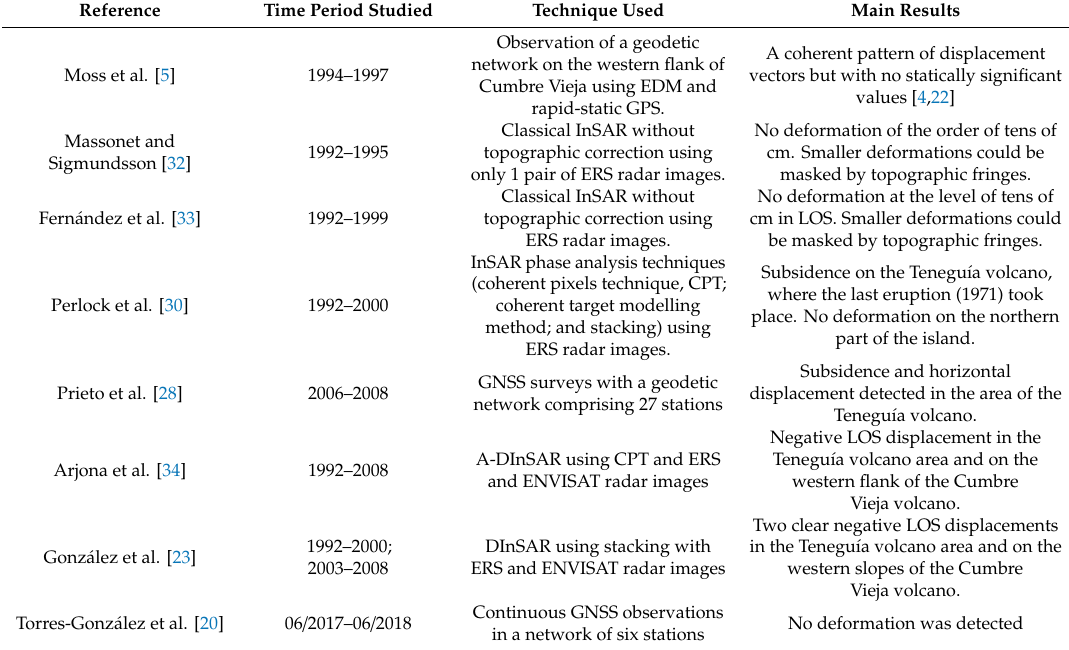
Table 1. Previous geodetic research for the La Palma